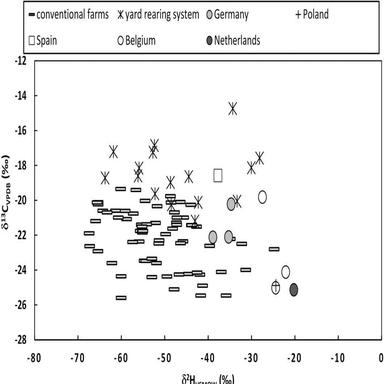
δ13C versus δ2 H values of meat samples.